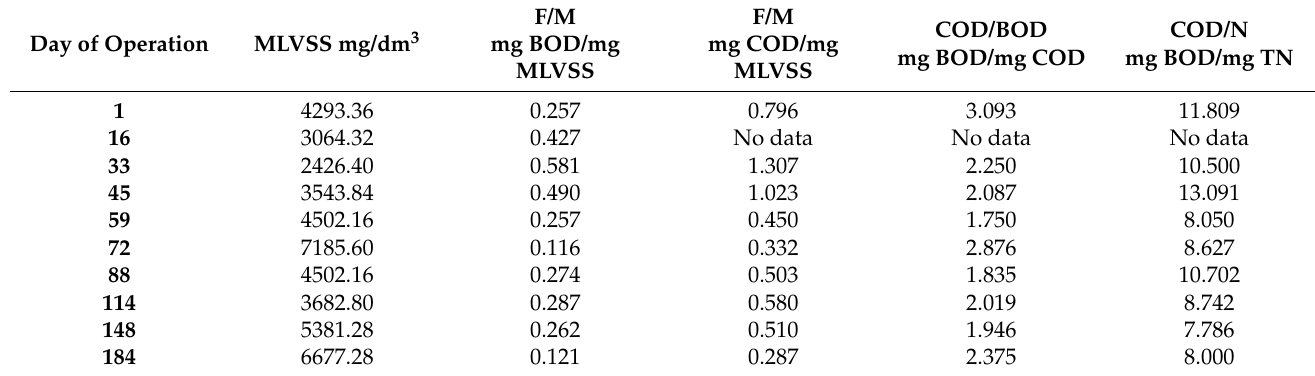
Table 2. F/M, COD/BOD, and COD/N